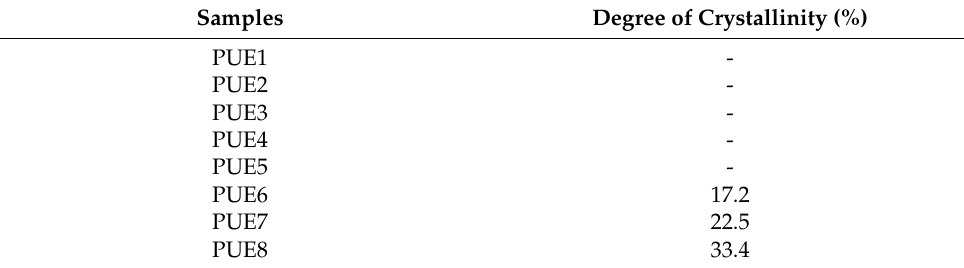
Table 2. Degree of crystallinity calculated from the XRD pattern.